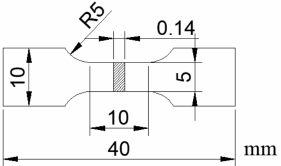
Figure 1. Dimensions of the dumbbell-type specimens used for the tensile